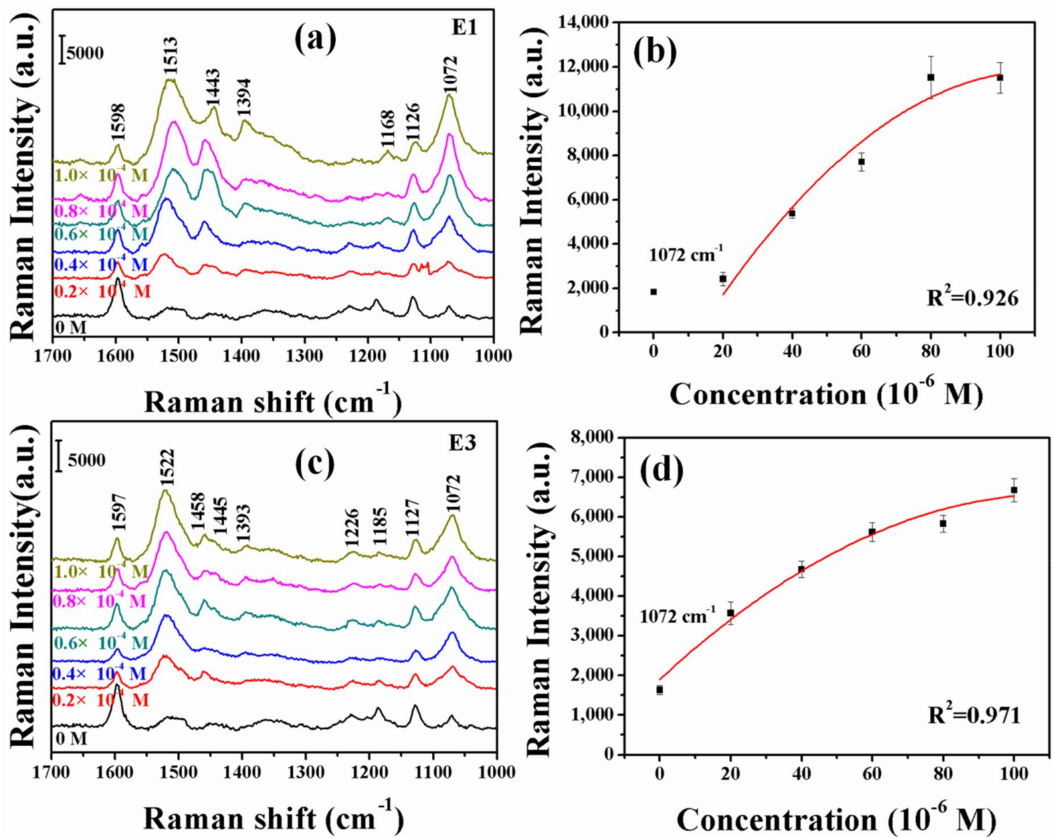
Figure 5. Raman test results after azo reaction of E1 ( a ) and E3 ( c ) at concentrations of 1.0 × 10 − 4 M, 0.8 × 10 − 4 M, 0.6 × 10 − 4 M, 0.4 × 10 − 4 M, 0.2 × 10 − 4 M and 0 M, respectively. Concentration-dependent SERRS intensities of the Raman bands at 1072 cm − 1 for E1 ( b ) and E3 ( d